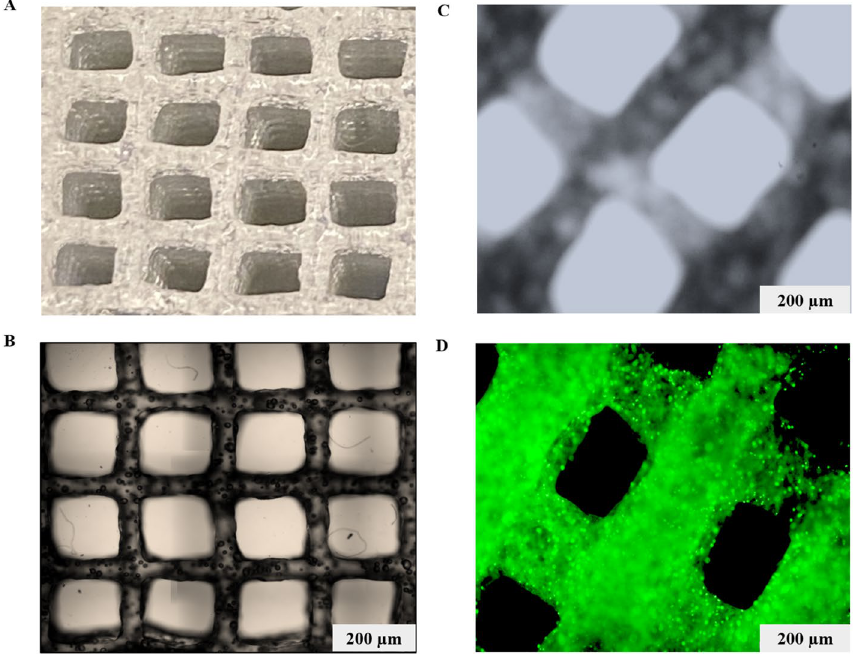
Figure 2. Extrusion uniformity and shape fidelity of printed scaffold. ( A ) Photographic image of ten layer printed scaffold with Ink H4-RGD. ( B , C ) Microscopic images showing the pore sizes and line width of printed scaffolds with Ink H4-RGD; ( D ) Microscopic images showing the cell (NSCLC-PDX) laden Ink H4RGD scaffold after staining with Calcein. Microscopic images were acquired by using Olympus Microscope IX71 and cellSens Standard software (version 1.16; Tokyo, Japan).